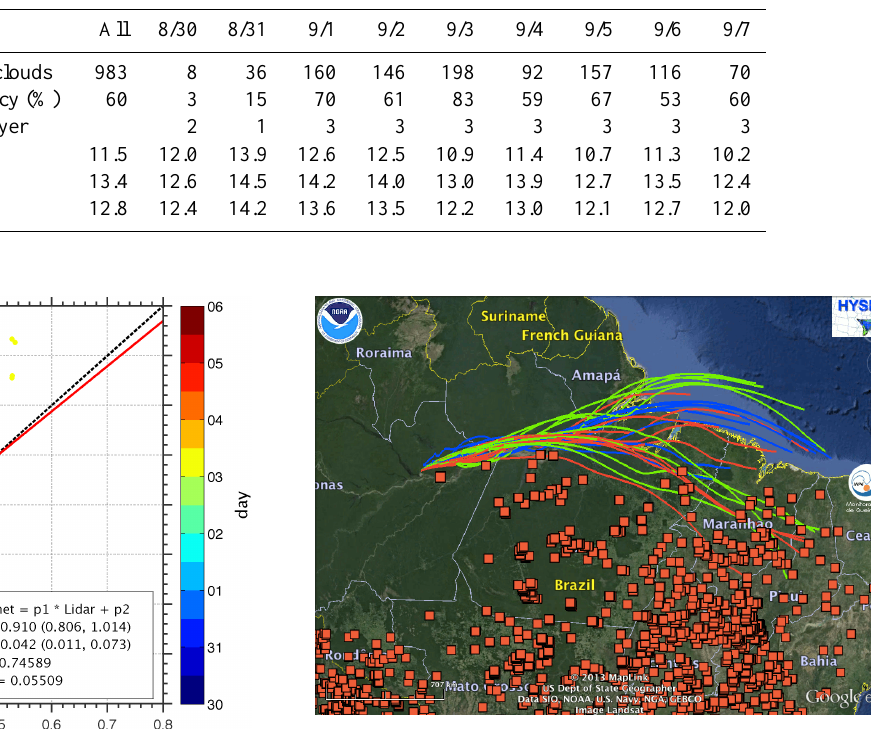
Figure 17. Back trajectories from the Hysplit model from NOAA and fire spots from Instituto Nacional de Pesquisa Espaciais (INPE)’s fire detection algorithm are shown over a Landsat image of the region obtained with Google Earth. Hysplit was run in en- semble mode, with trajectories starting from 1.5km on 12:00UTC 3 September. All fire spots from 30 August to 1 September are